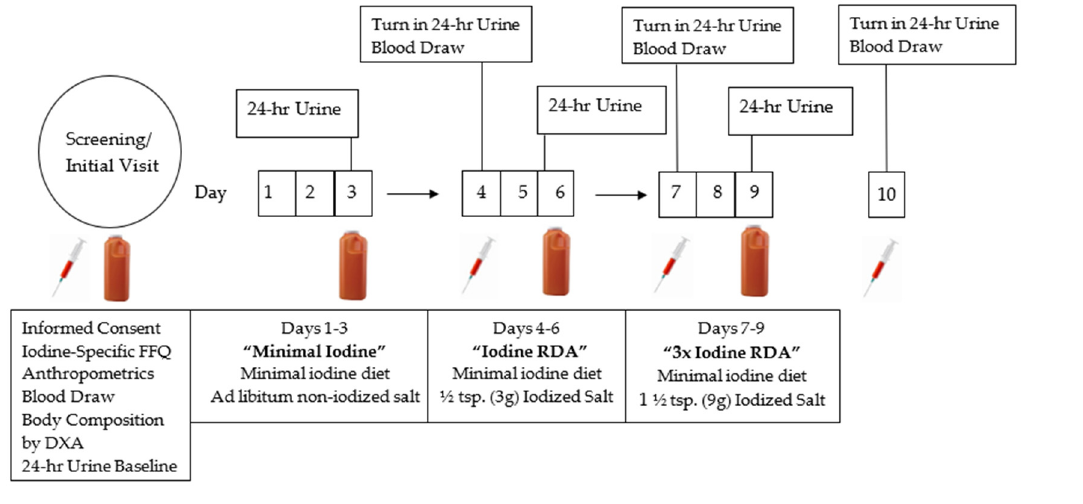
Figure 1. Protocol schematic showing the iodine titration diet progression at the initial visit and ending on day 10. The “syringe” graphic indicates scheduled blood draws and “orange urine collection jugs” indicate 24 h urine collections time points. A minimal iodine diet is defined at the bottom of the schematic.